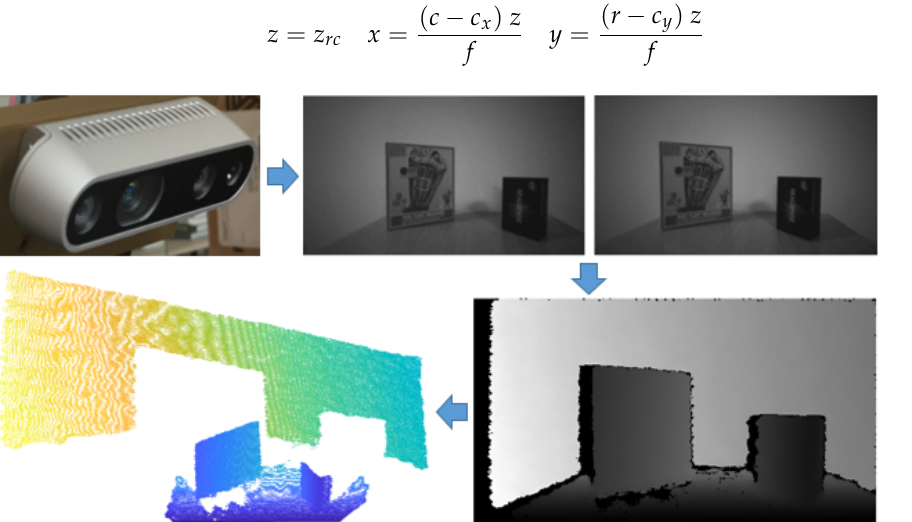
Figure 4. Acquiring of a depth image through inverse disparity, determined by corresponding point pairs of the left and right